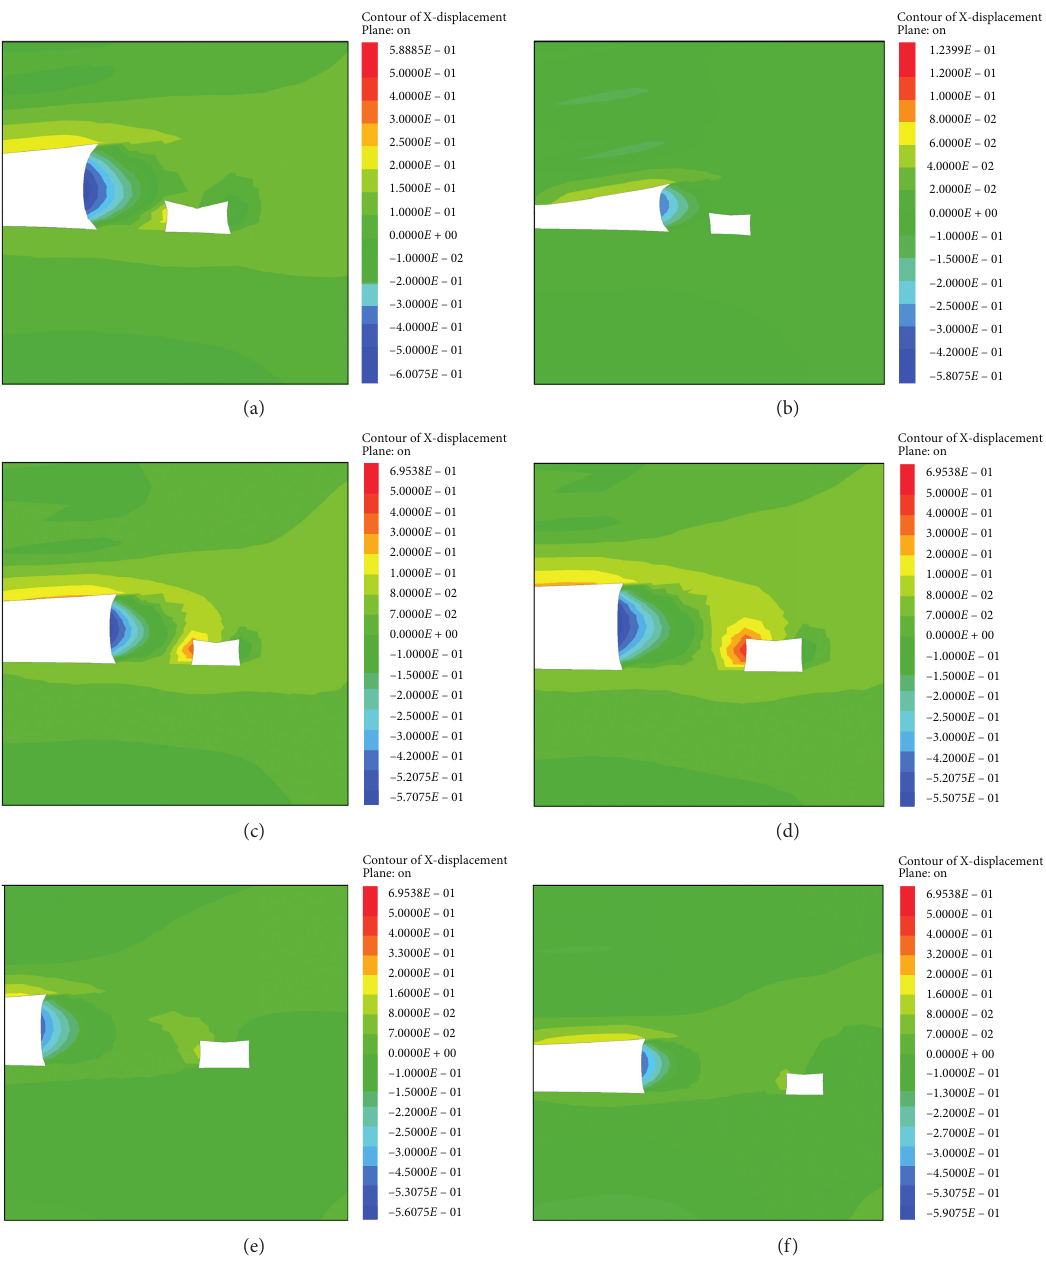
Figure 17: Horizontal displacement of coal pillar in different width section: (a) 4m, (b) 5m, (c) 8m, (d) 10m, (e) 13m, and (f)